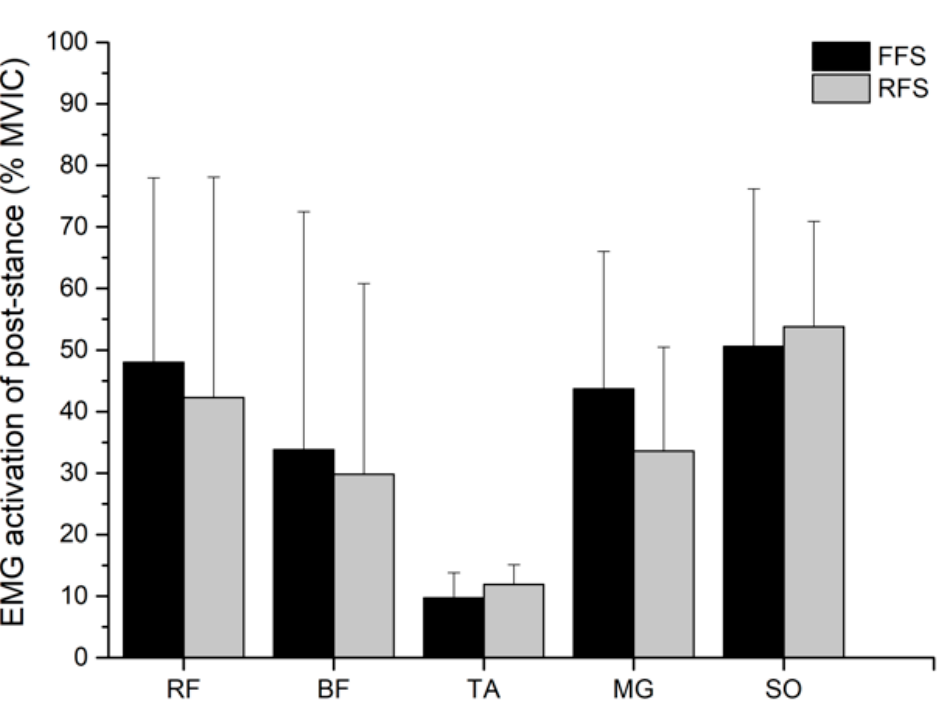
Figure 6. Muscle activity of FFS and RFS pattern during stance phase. Note: FFS = forefoot strike patter; RFS = rearfoot strike pattern; RF = rectus femoris; BF = biceps femoris; TA = tibialis anterior; GM = gastrocnemius medialis; SO = soleus.